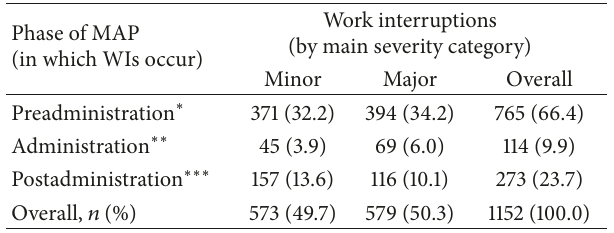
Table 3: The frequency and percentage distribution of the overall work interruptions by the characteristics of individuals and working environment ( 𝑛 = 1152